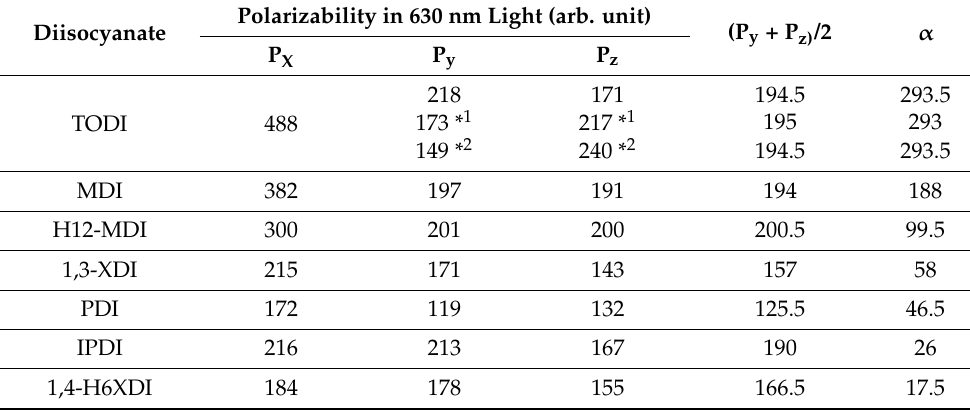
Table 4. Polarizability calculation results. The diisocyanates with both ends methoxylated were used in the polarizability calculation.